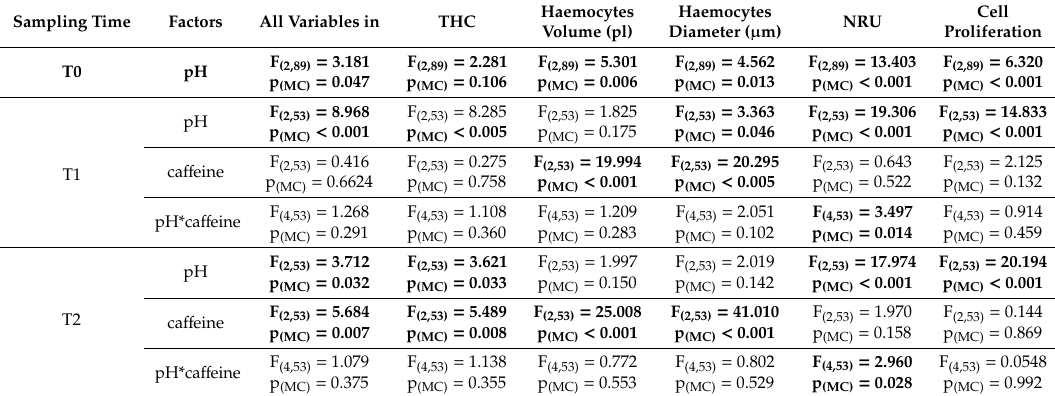
Table 2. PERMANOVA results. Pseudo-F values (indicated as F) and Monte Carlo p -values for all the parameters and for each single parameter measured in hemocytes of Mytilus galloprovincialis throughout the experiment performed at three pH levels (pH N, pH − 0.4 and pH − 0.7), in the absence (T0: 7-days exposure) or in the presence of 0.05 and 0.50 µ g / L ca ff eine (T1: from day 7 to 14; T2: from day 14 to 21)